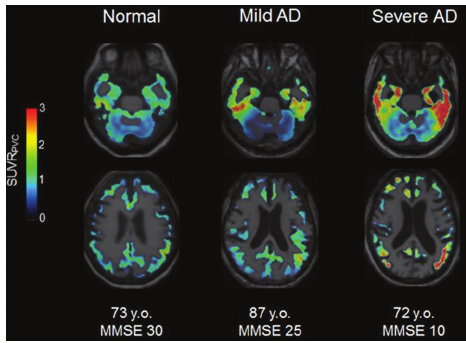
Figure 5. 18 F-THK5117 PET imaging in a normal elderly subject (Mini Mental State Examination (MMSE) 30, 73 y.o.), patient with mild AD (MMSE 25, 87 y.o.) and patient with severe AD (MMSE 10, 72